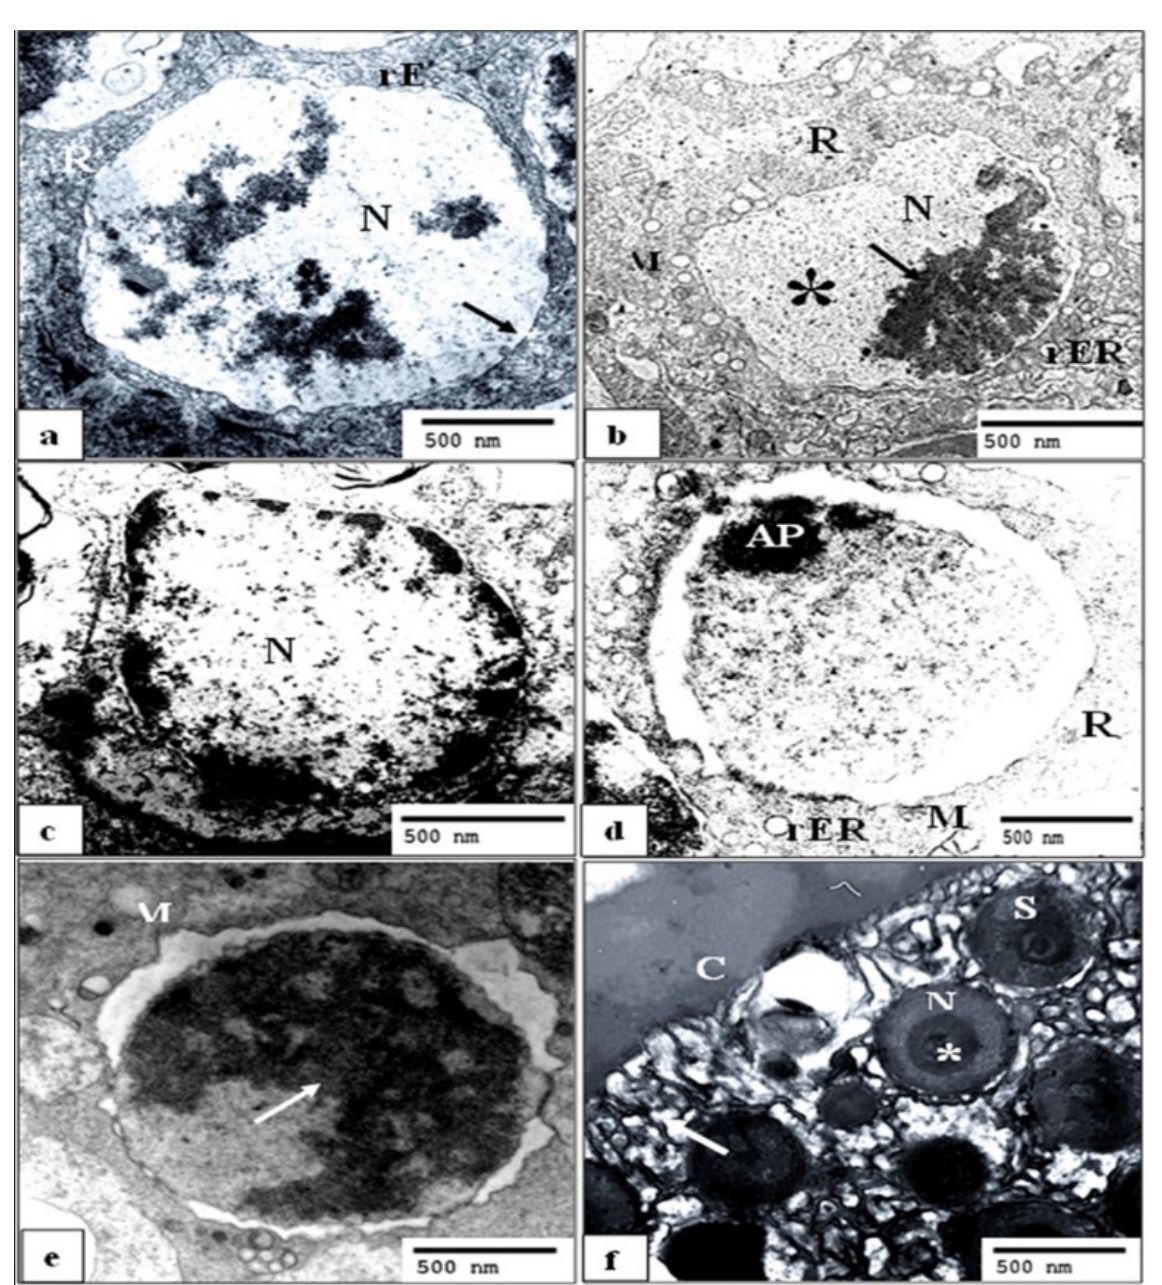
Figure 5. Diakinesis stage has a nucleus (N) with thick chromatids, dispersed nuclear envelope (arrows), scant cytoplasm contains few rough endoplasmic reticulum (rER) and free ribosomes (R) ( a ). Secondary spermatocytes stage with small nucleus (N), nucleoplasm (star), tightly condensed chromatin (arrow), vesicular endoplasmic reticulum (rER), small rounded mitochondria (M), and ribosomes (R) ( b ). Early spermatid with large euchromatic nucleus (N) and heterochromatin blocks in poor cytoplasm ( c ). Mid spermatid has a nuclear pole (NP) with small clumps of chromatin, acrosome pole (AP) with acrosomal vesicle, ribosomes in poor cytoplasm (R), lytic mito-chondria (M), vesicular endoplasmic reticulum (rER) ( d ). Late spermatid stage with half-moon heterochromatic nucleus (arrow) and lytic mitochondria (M) in poor cytoplasm ( e ). Spermatophore surrounded by a thick capsule (C), mature sperm (Sz), acrosome(star) nucleus (N), and cell boundaries (arrows). Mature spermatozoa have a fully developed cylindrical acrosomal core between the nuclear cup and acrosomal region and a thin layer of lamellae. The radial arms are continuous with the nuclear cup. The apical cap of sperm is a specialized, thickened structure ( f ). The acrosomal region’s body surrounds an “acrosomal tubule, which extends from the apical cap proximally to the central region bordering the nuclear